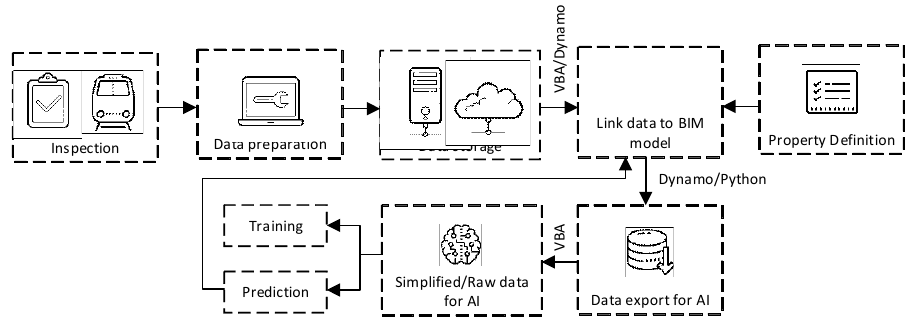
Figure 3. Dynamo for information exchange.